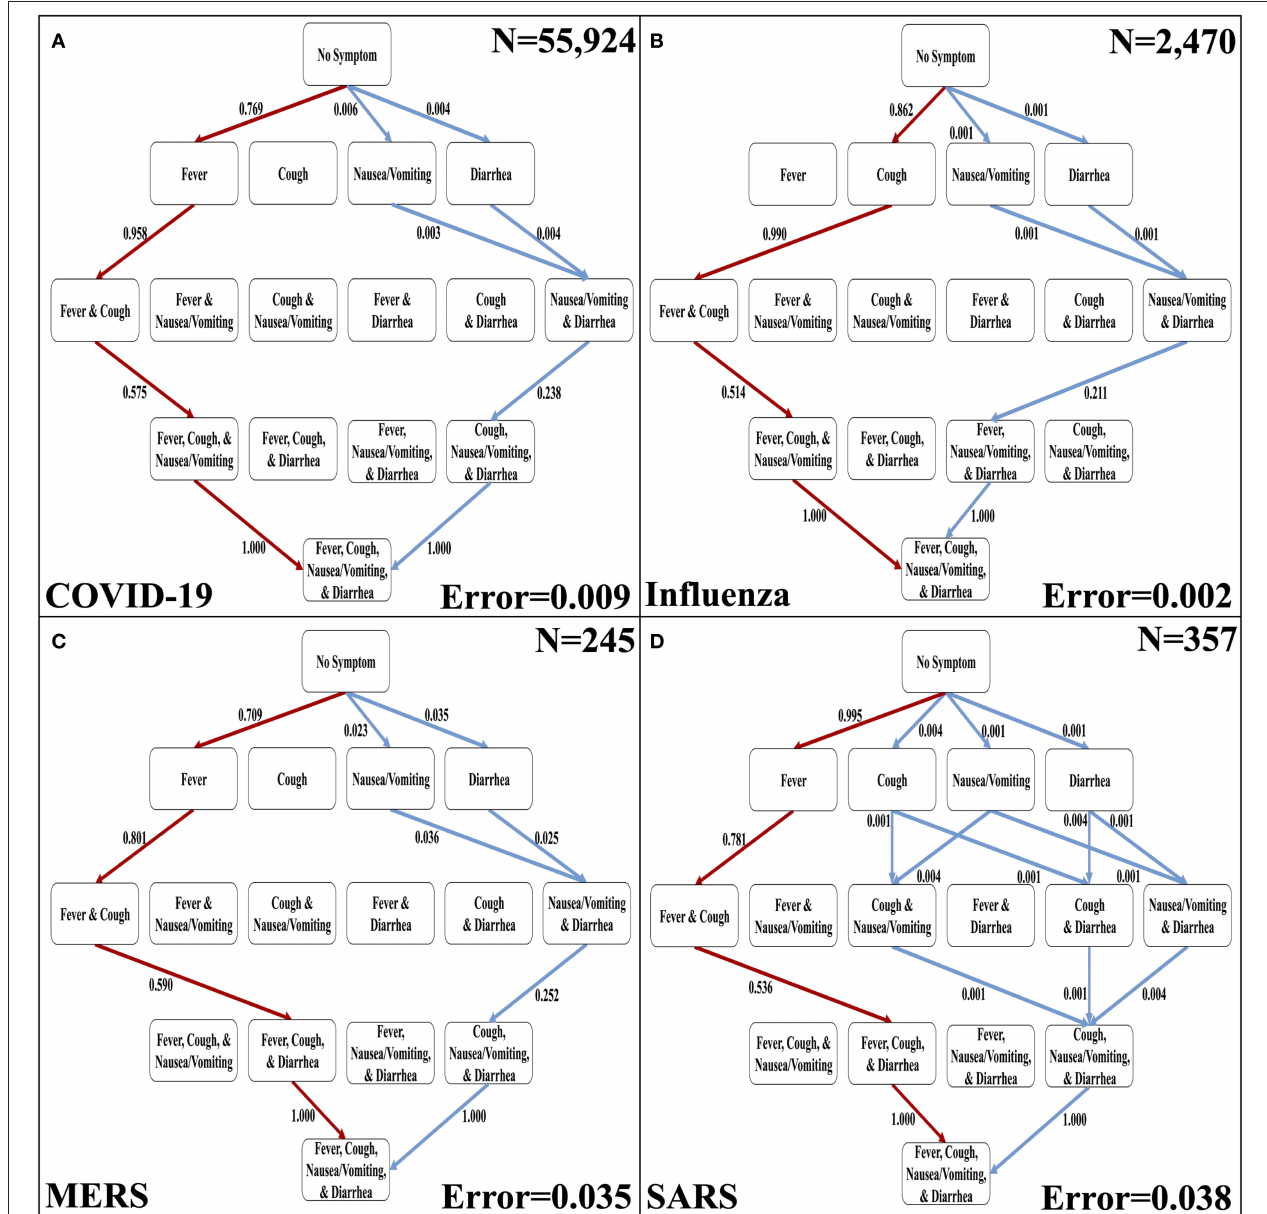
FIGURE 3 | The most likely and least likely paths of discernible symptoms in respiratory diseases. (A) The most likely paths (red) and least likely paths (blue) in a Hasse Diagram for COVID-19 symptoms. (B) The most likely paths (red) and least likely paths (blue) in a Hasse Diagram for influenza symptoms. (C) The most likely paths (red) and least likely paths (blue) in a Hasse Diagram for MERS symptoms. (D) The most likely paths (red) and least likely paths (blue) in a Hasse Diagram for SARS symptoms. For each diagram, the most and least likely paths are determined from the transition probabilities that are depicted on the edges. Additionally, error of transition probabilities and sample size ( N ) are